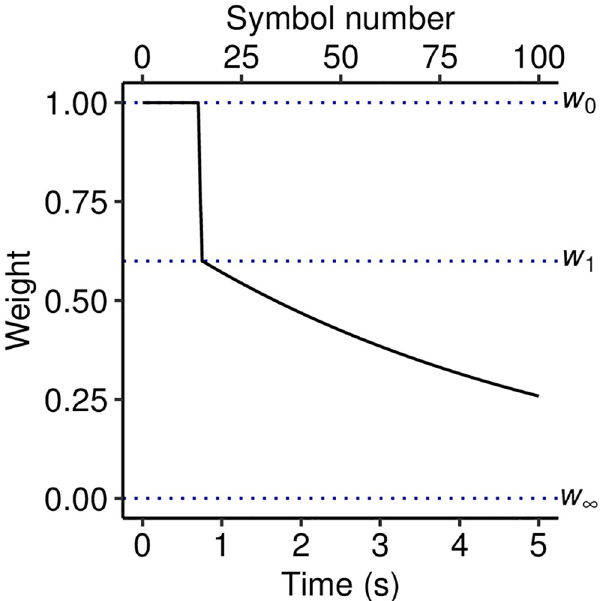
Fig 10. Illustrative weight decay profile. This figure plots the weight of an n -gram of length one as a function of relative observer position, assuming that new symbols continue to be presented every 0.05 seconds. Model parameters are set to t = 2, n = 15, w 0 = 1.0, t 0.5 = 3.5, w 1 = 0.6, and w 1 = 0, as optimized in Experiment b b